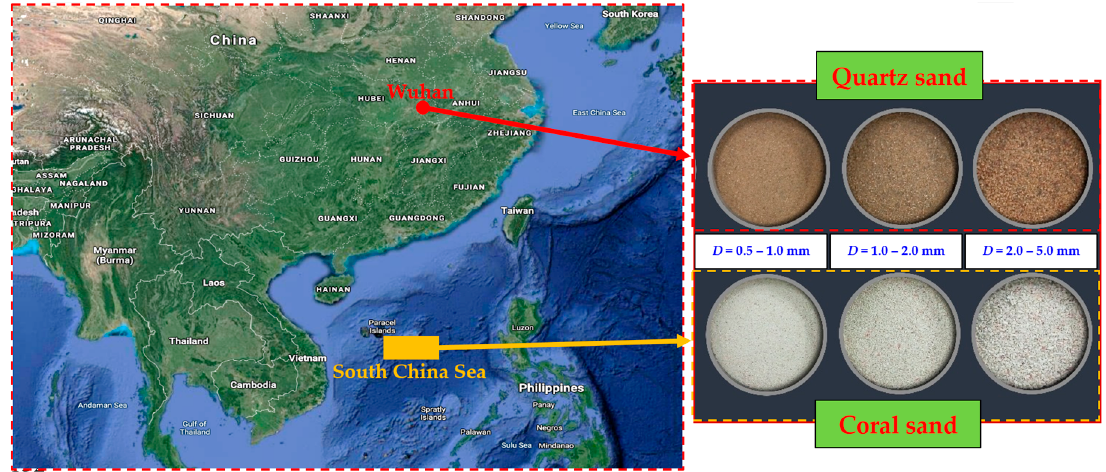
Figure 1. Coral sand and quartz sand with different particle sizes.